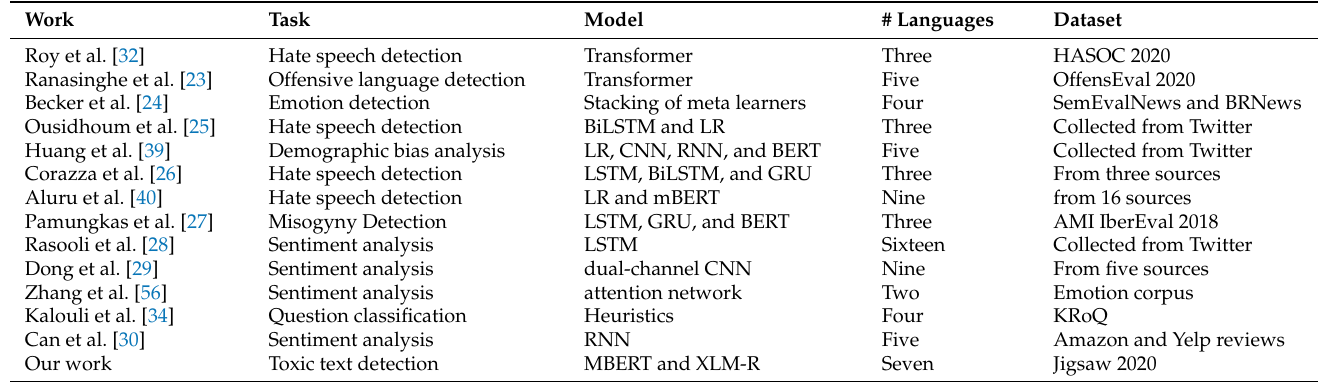
Table 2. A comparative table of prior studies on multilingual text classification